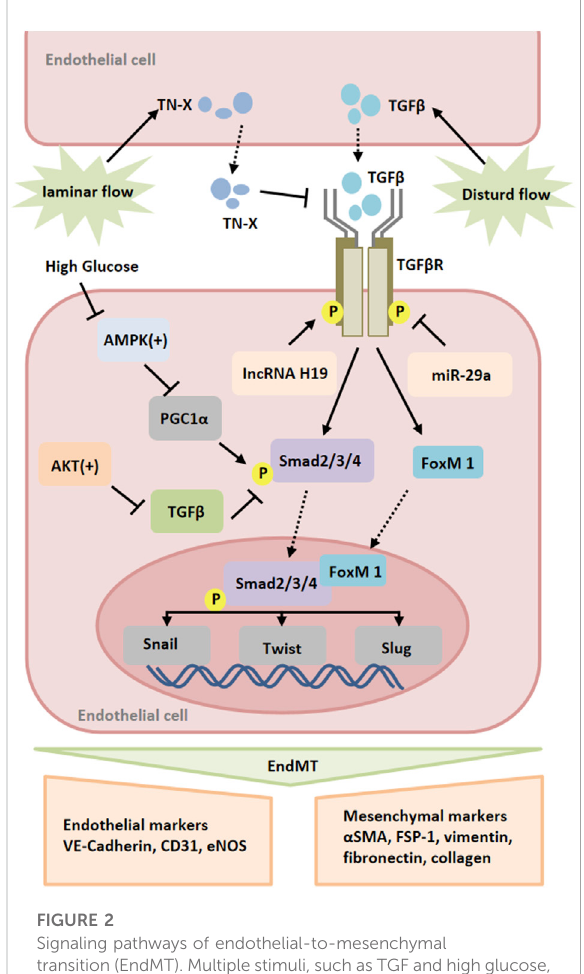
Signaling pathways of endothelial-to-mesenchymal transition (EndMT). Multiple stimuli, such as TGF and high glucose, induce the expression of transcription factors, such as Snail, Slug and Twist, which promote EndMT. These processes are regulated by various mediators, such as miR-25-3p, lncRNA H19, Smad2/3/4, FoxM1, AMPK and AKT. Abbreviations: AMPK, 5 ′